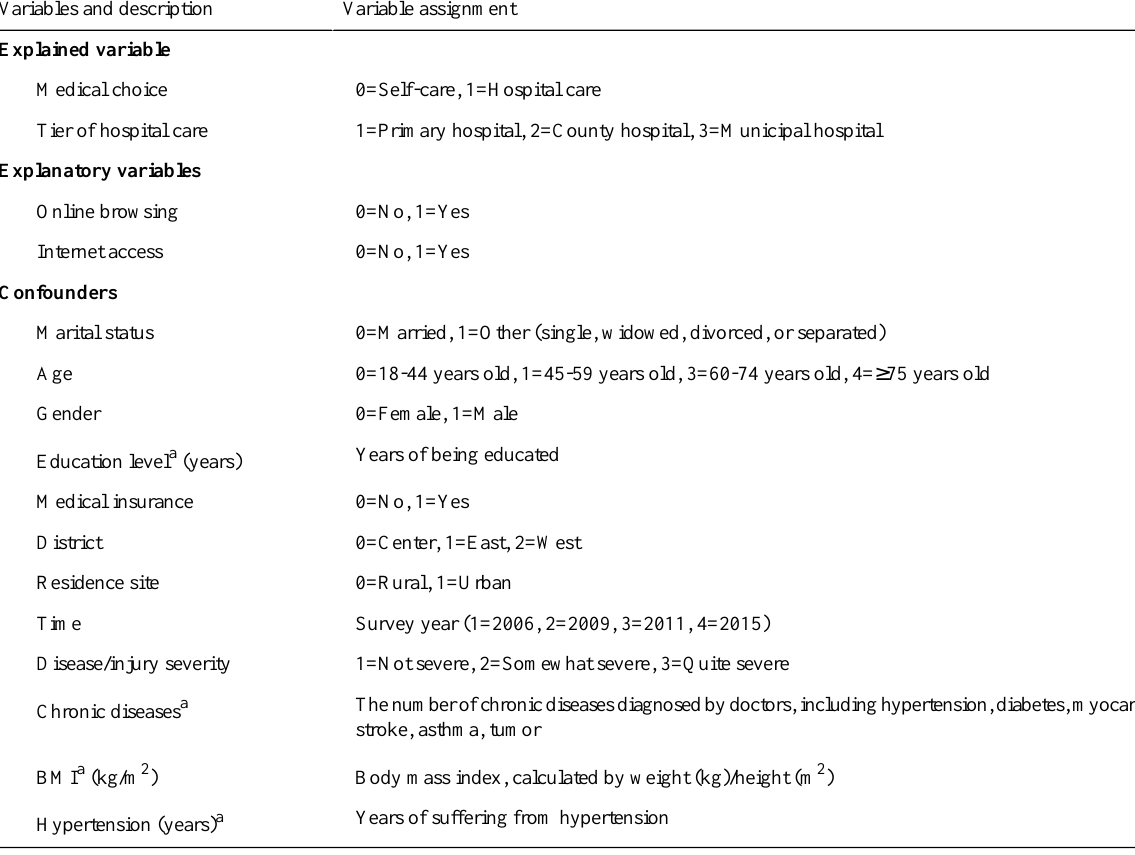
Variable assignmentVariables and